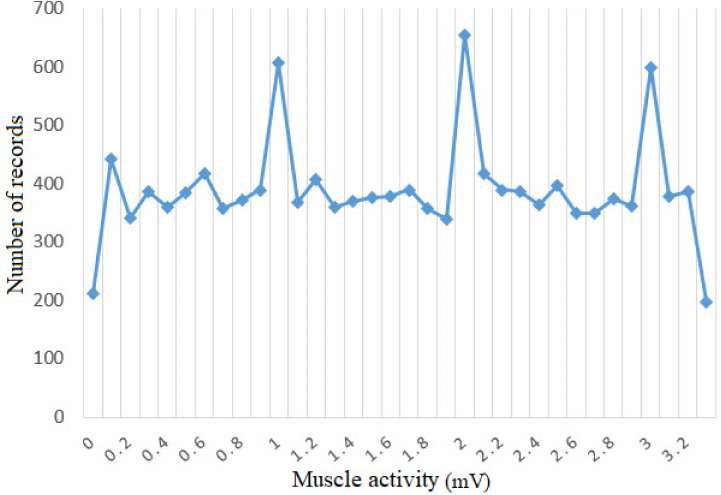
Figure 10. Histogram for muscle activity after